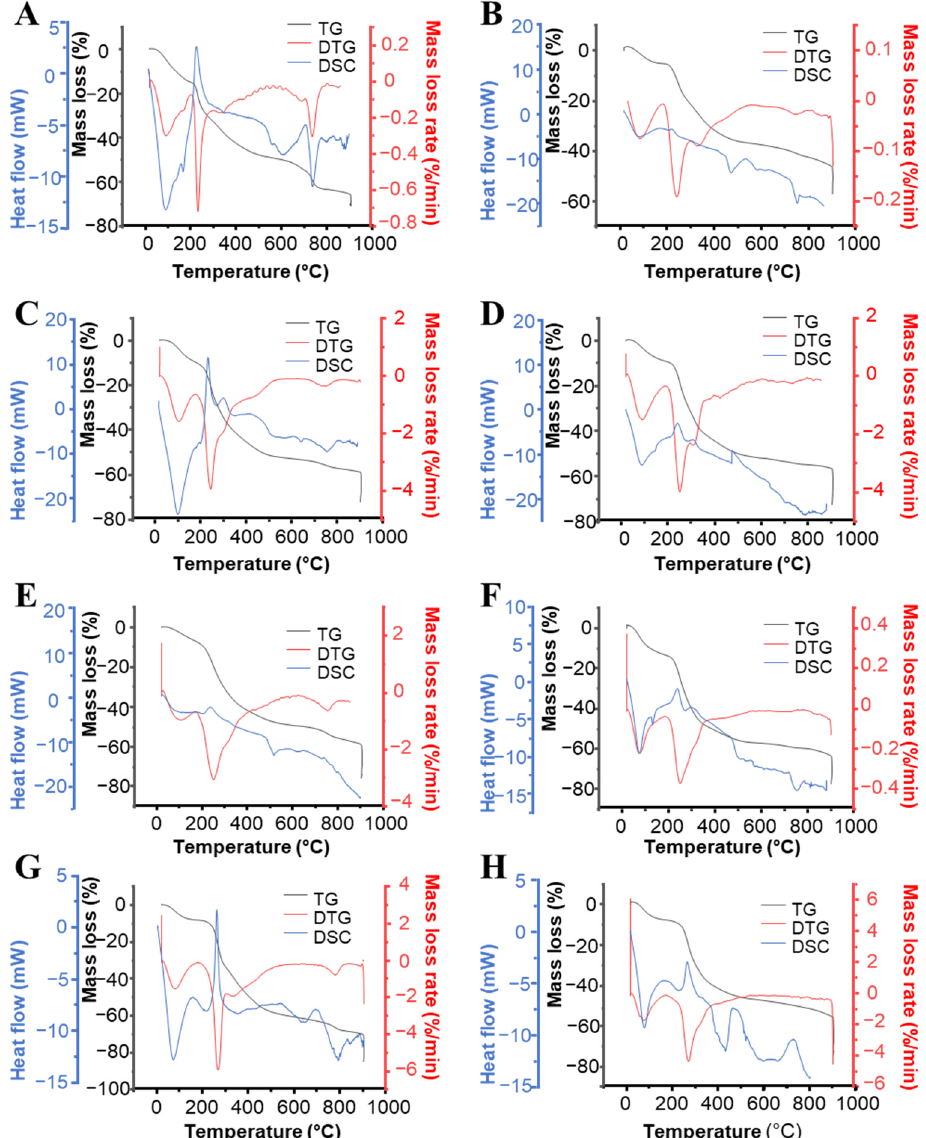
Figure 2. TG, DTG, and DSC curves of the studied seaweeds. Different figures show the studied algae: Part ( A ), Ulva rigida ; ( B ), Codium tomentosum ; ( C ), Undaria pinnatifida ; ( D ), Laminaria ochroleuca ; ( E ), Himanthalia elongata ; ( F ), Saccharina latissima ; ( G ), Porphyra purpurea ; ( H ), Palmaria palmata .